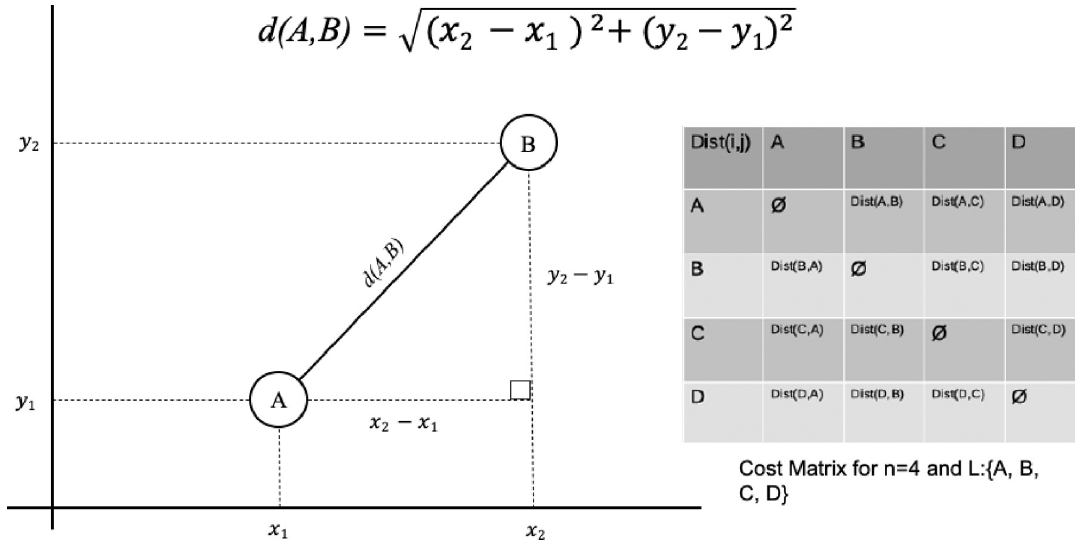
Fig 3. A sample cost matrix for 4 nodes and the Euclidian distance between each pair of nodes.